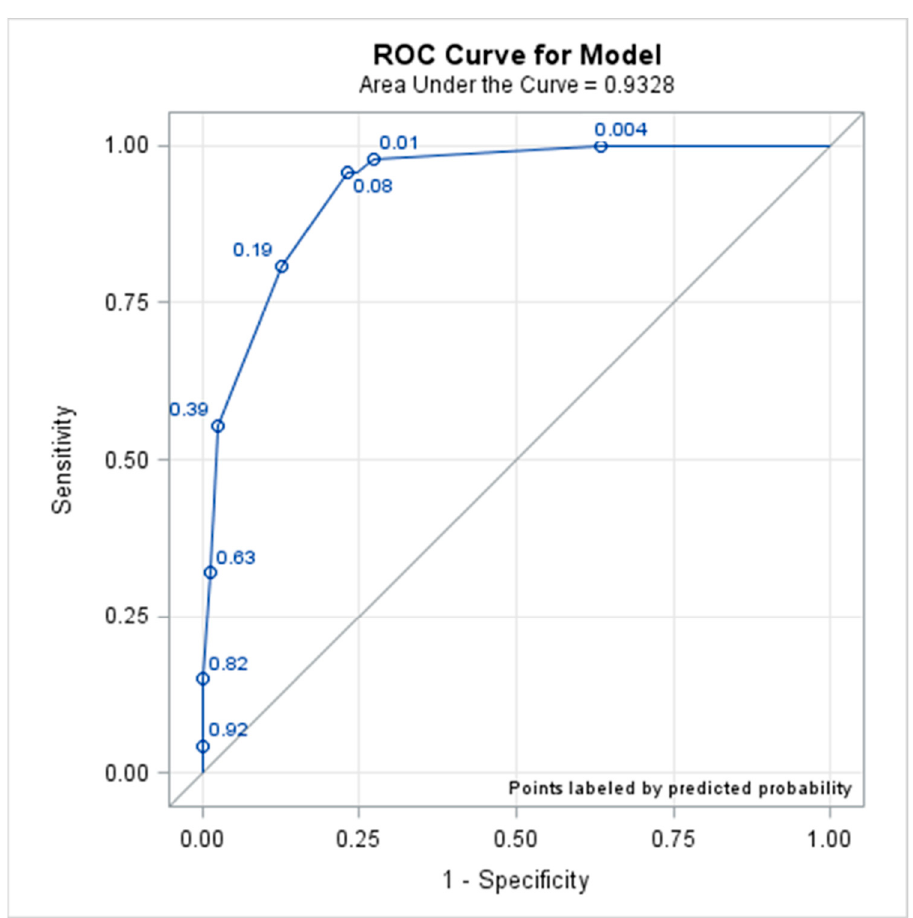
Figure 2. Receiver operating characteristic (ROC) curve for the logistic model with the sensitivity and specificity at the cutoff points for clinical and laboratory data.